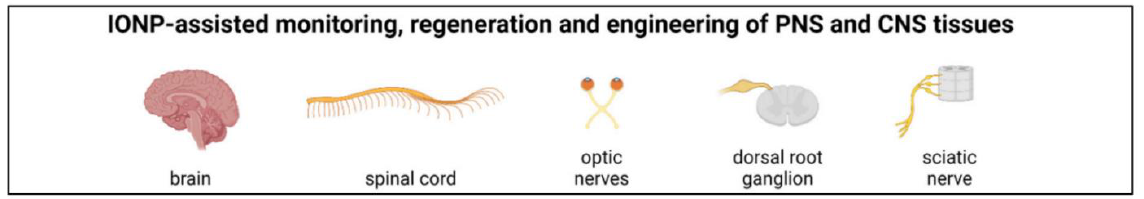
Figure 7. Probable targets for iron oxide nanoparticles-assisted tissue engineering and regenerative tissue engineering for both peripheral and central nervous system [157].